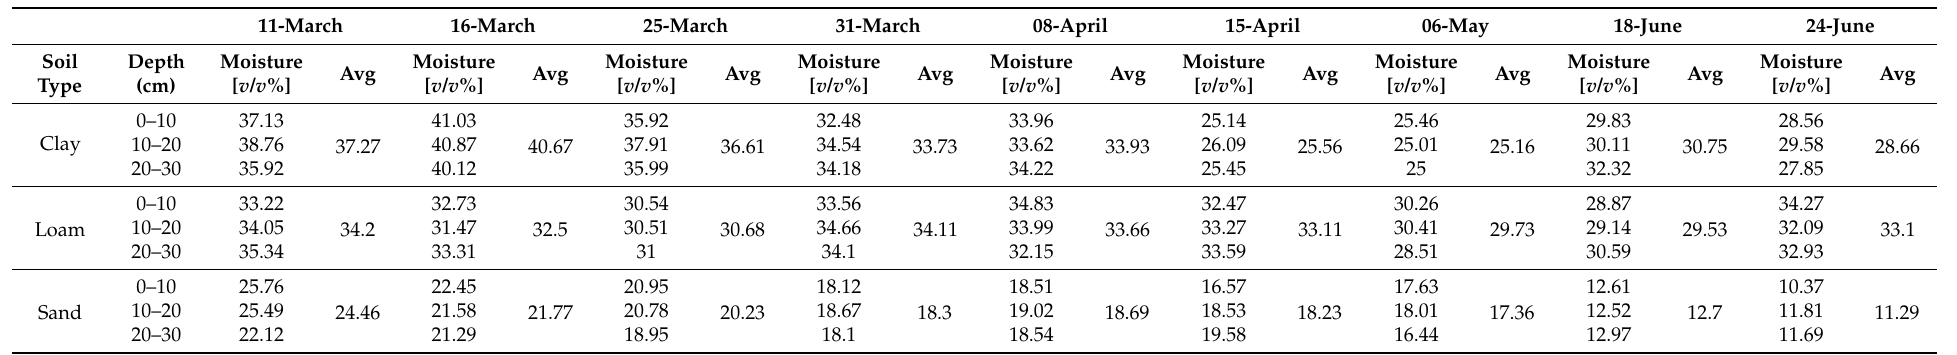
Table 3. Volumetric water content from Gravimetric